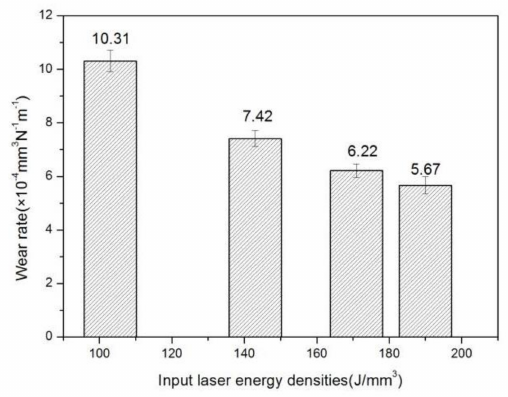
Figure 14. Wear rates of the SLM as-built parts under different